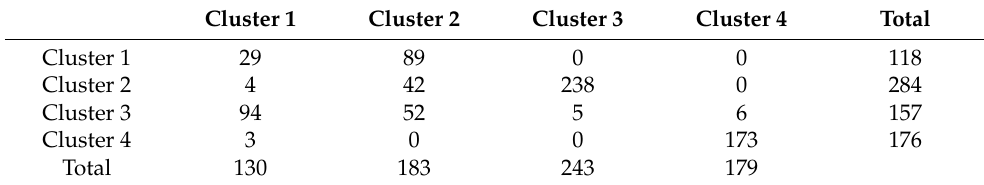
Table 3. Crosstabulation of the unweighted (columns) and weighted (rows) 4-cluster classifications.